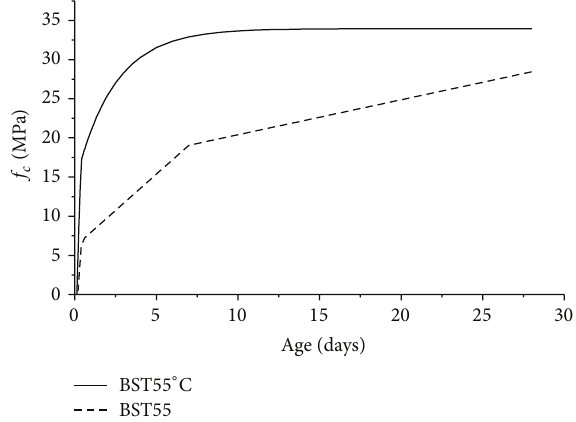
Figure 7: Simulated and experimental strength development curves of heat treated sand concrete at 55 ∘ C.